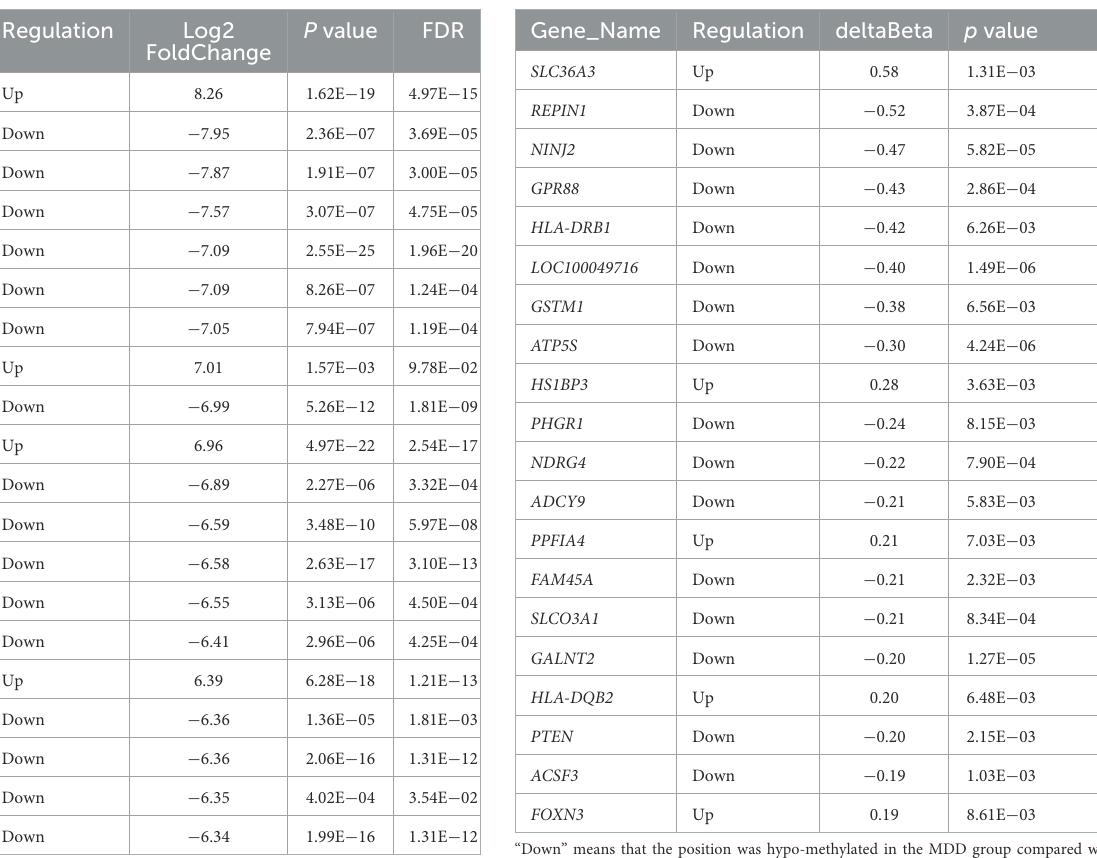
TABLE 3 Top 20 differential expression DNA methylation positions between first-episode, drug-naive adolescents with MDD and